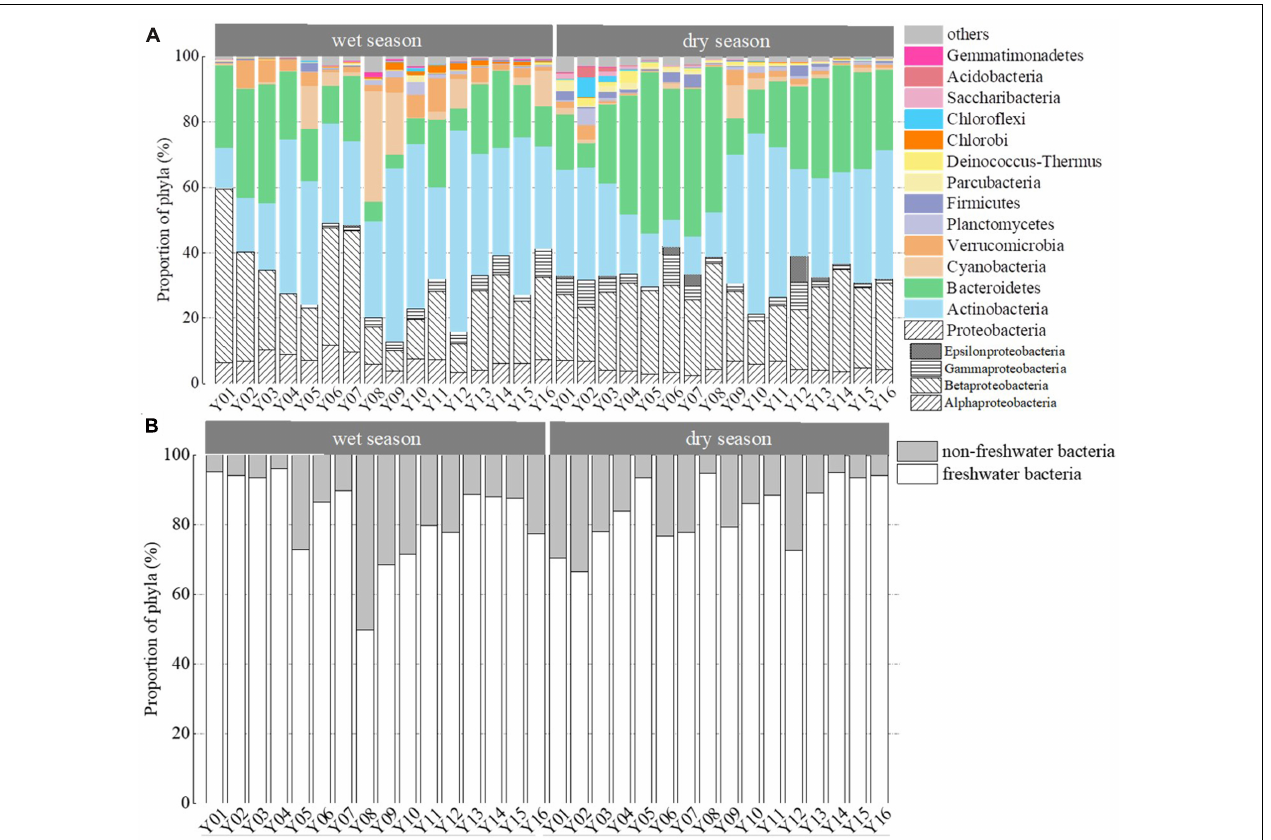
FIGURE 4 | Relative abundances of bacterioplankton communities from the wet and dry seasons, arranged from upstream to downstream. Compositions are shown as (A) bacterioplankton phyla distributions and (B) freshwater and non-freshwater bacterial OTU distributions. Taxa with relative abundances < 1% are grouped as